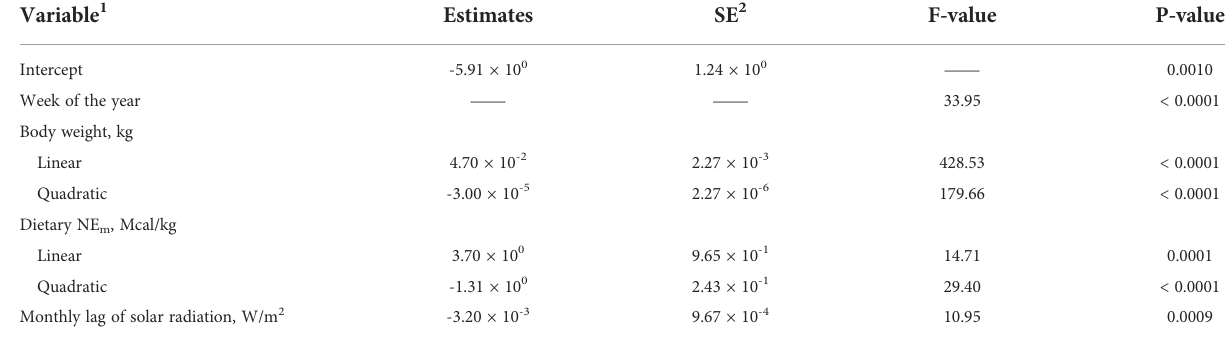
TABLE 6 Base model with monthly lag of solar radiation.